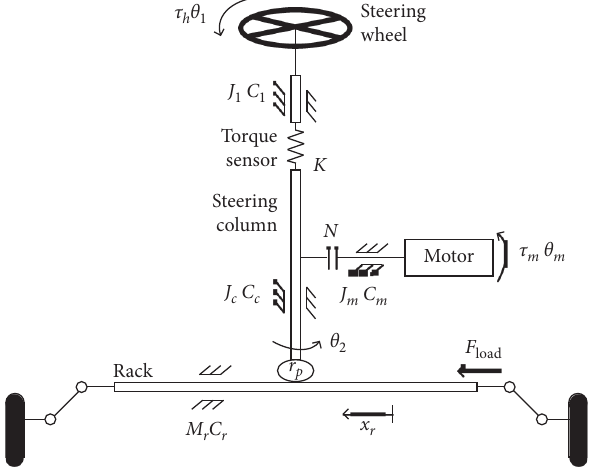
Figure 1: EPS system model. Table 1: Parameters and variables.